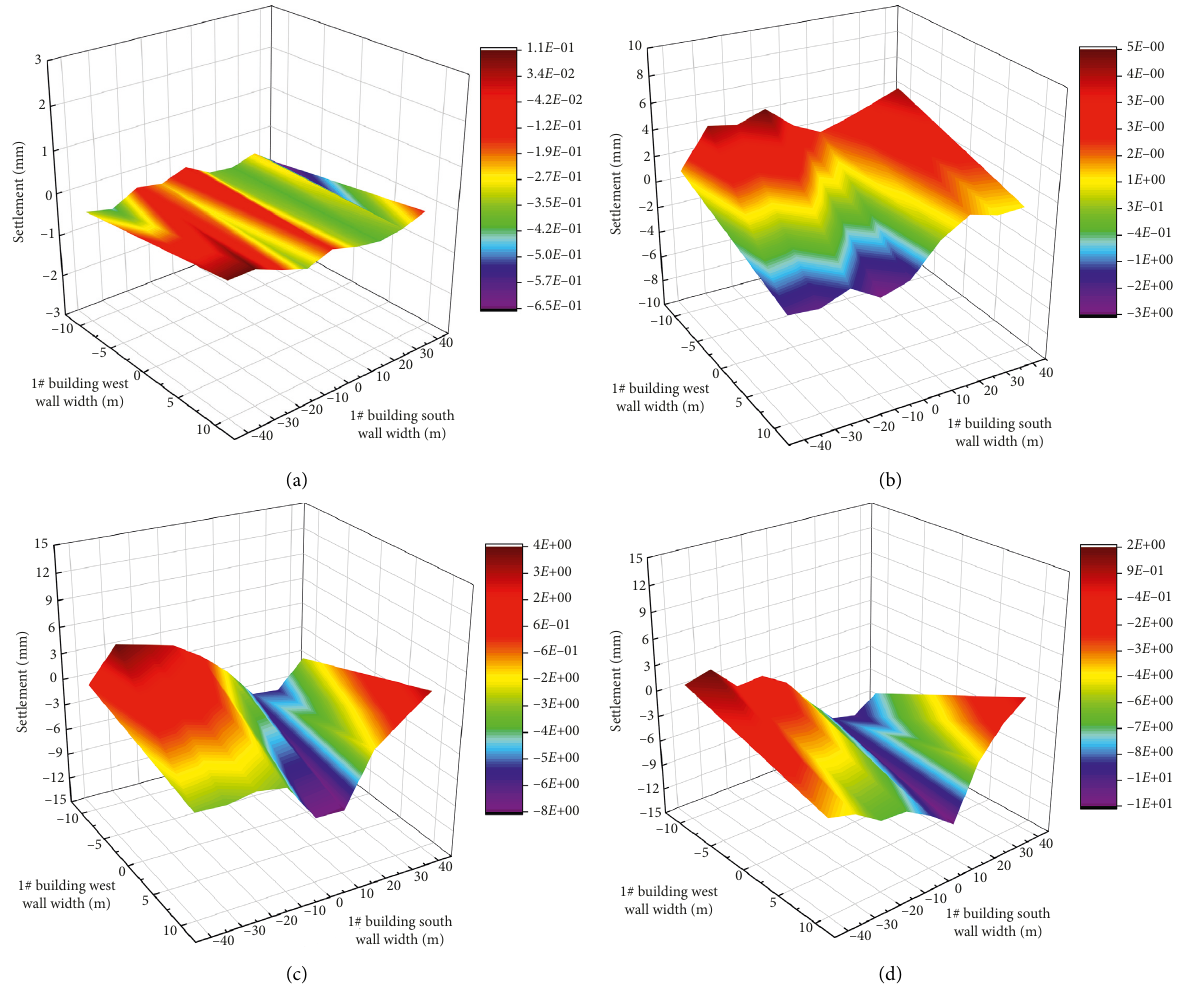
Figure 8: Deformation of buildings at various critical moments of shield cutting pile group construction. (a) Deformation of buildings when shield tunnels are not under construction. (b) The left-line shield cutter head starts to cut the pile group composite foundation. (c) Left-line shield tail separated from pile group composite foundation. (d) The shield tail of the left line is away from the pile group composite foundation for 15 days.